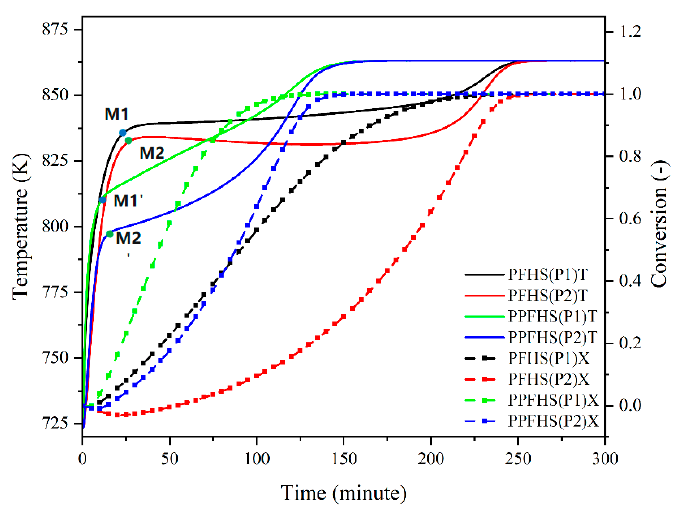
Figure 6. Temperature (T) and conversion (X) changed over time at the two-point probes (P1, P2) with respect to PFHS and PPFHS reactor (dehydration, ε = 0.5, u = 25 m/s).